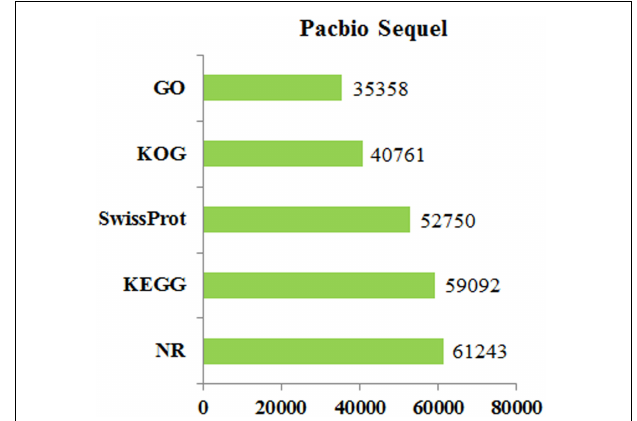
FIGURE 3 | Annotated gene number of single-molecule real-time (SMRT) sequencing.